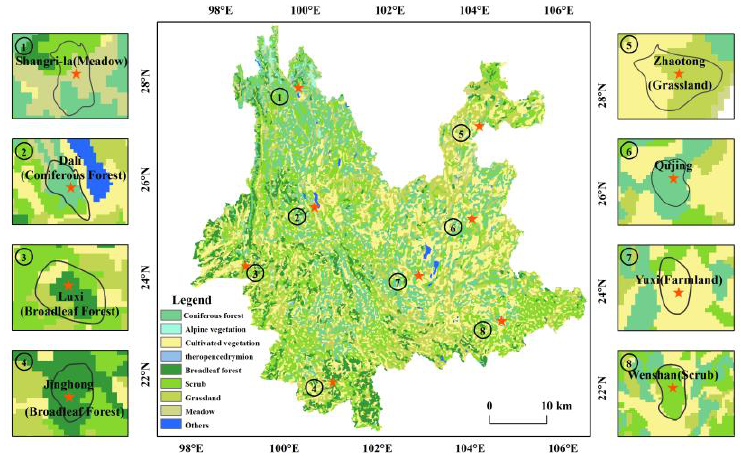
Figure 10. Typical regional distribution in Yunnan Province.